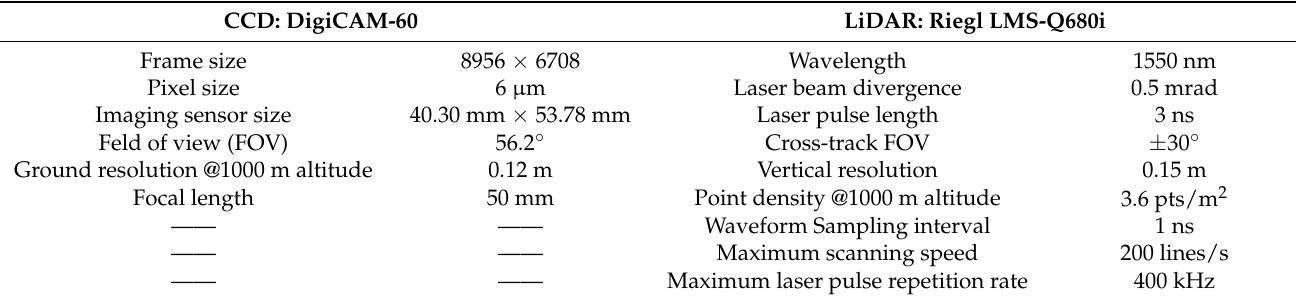
Table 1. The parameters of LiCHy airborne remote sensing system platform.